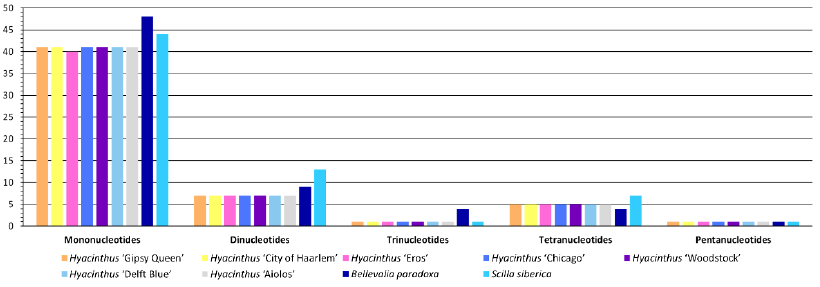
Figure 4. Abundance of SSRs classified by different repeat types among the nine studied chloroplast genomes.